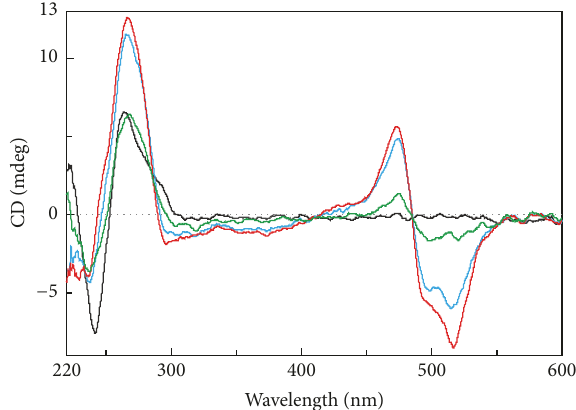
Figure 8: CD titration spectra of 27 𝜇 M HPV25/1 (d(GGG- AGCGGGAC-TGGGACCGGGACCG-GG)) with TO. 0, 2.5, 5, and 7.5 molar equivalents of TO are represented by black, green, brown, and red lines, respectively. Each sample was measured in a modified 25 mM mBR buffer containing